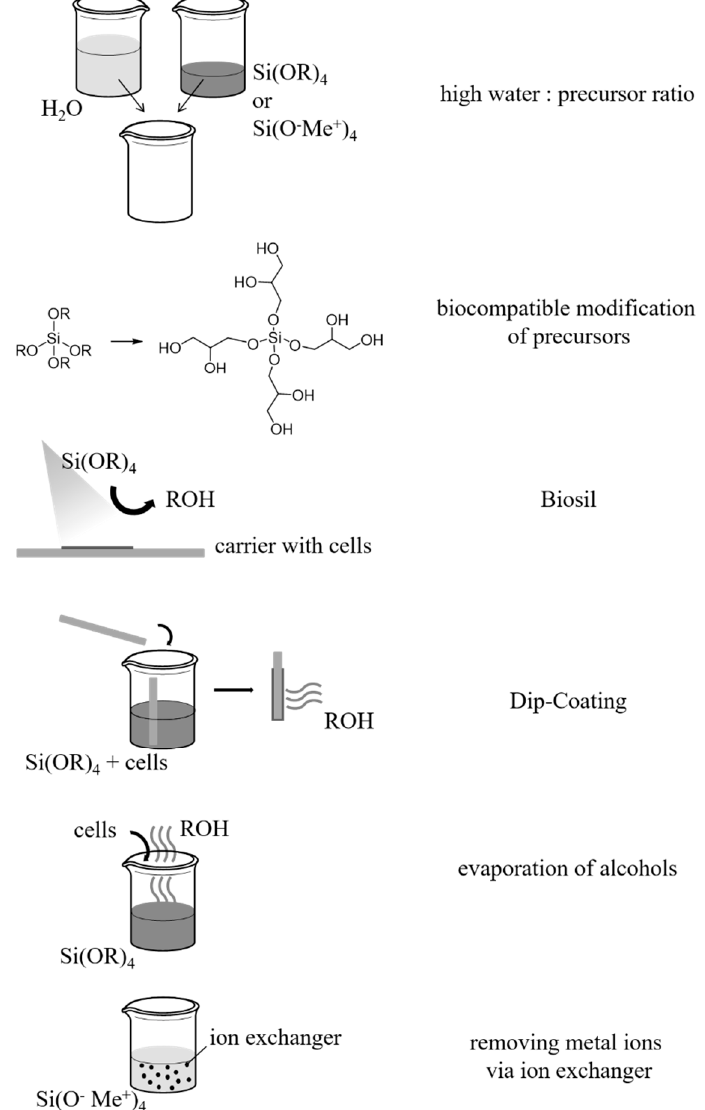
Figure 6. Schematic representation of methods for mitigating the concentration of by-products in order to increase the biocompatibility of the sol–gel method for hydrogel production.